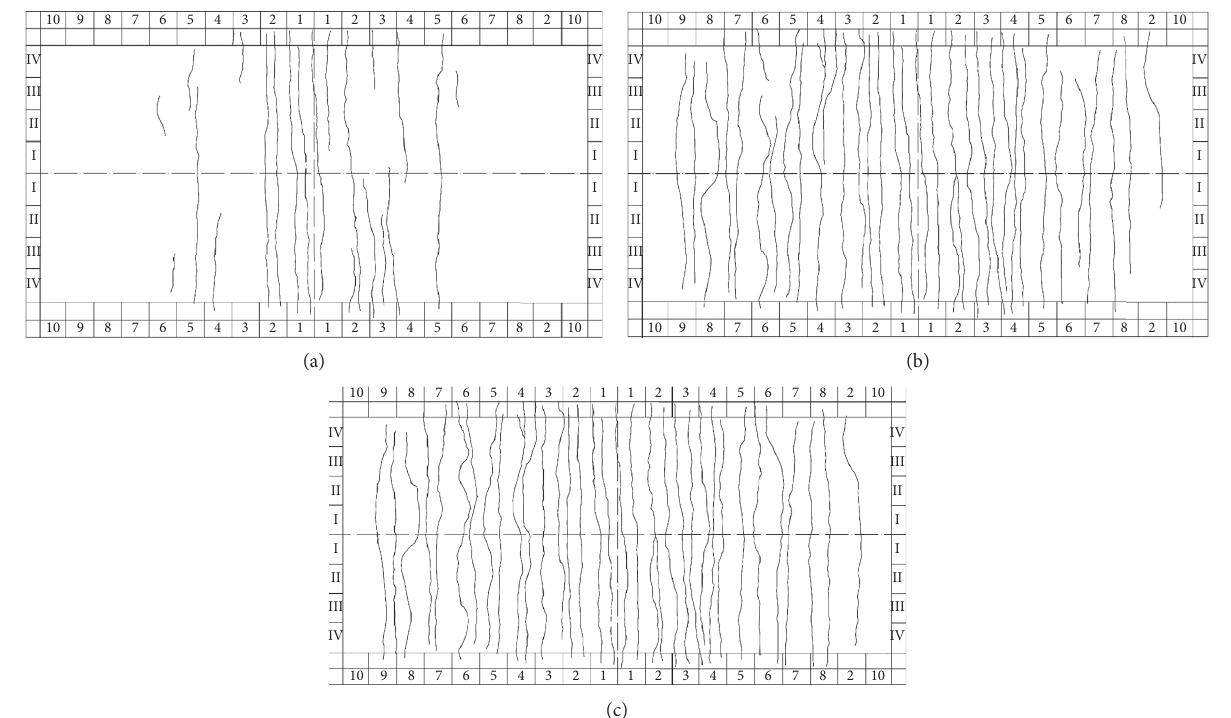
Figure 16: Distribution of cracks in the concrete slab of PLG-1. (a) 380kN. (b) After 250,000 cycles. (c) After 1 million cycles.